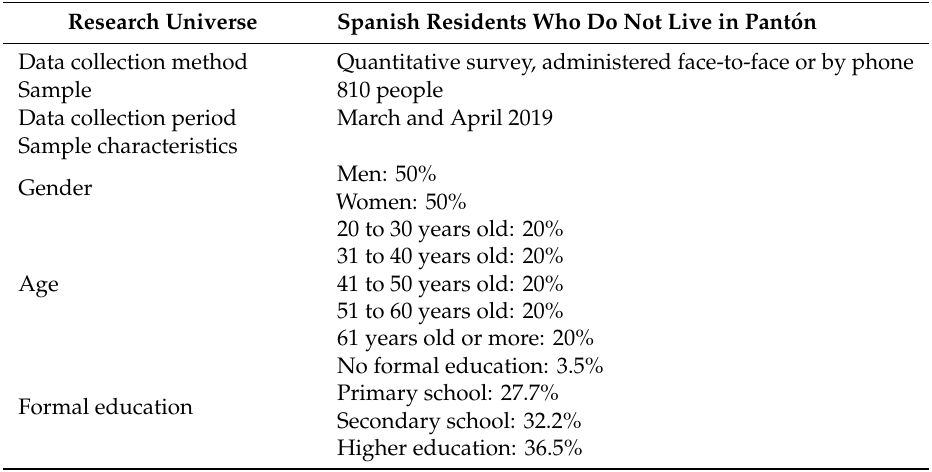
Table 1. Technical details of the data collection and sample